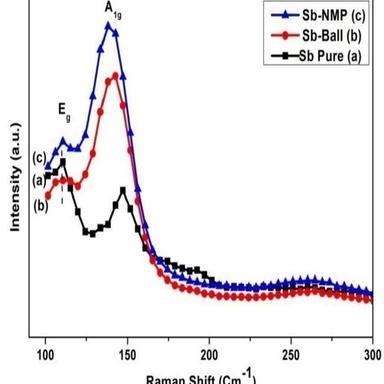
XRD (a) pure Sb and (b–c) ball-milled Sb, NMP treated Sb. Fig. 3. Raman spectra (a) bulk antimony, (b) ball-milled antimony (c) antimonene (8 h).